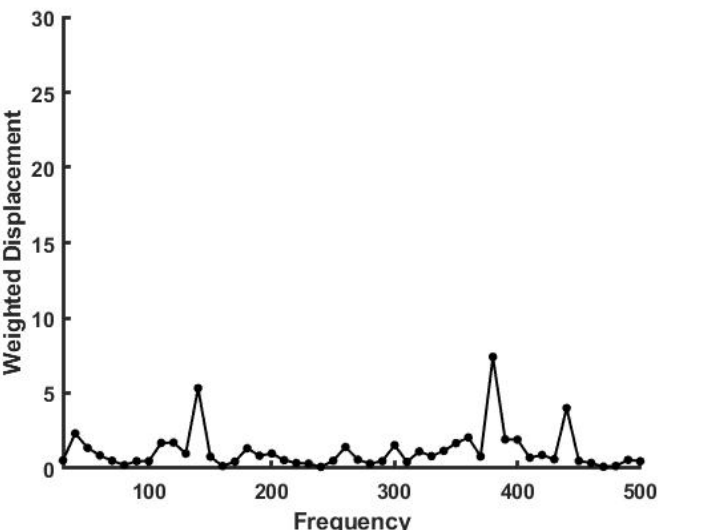
Figure 2. Weighted displacement in μ m vs frequency in Hz for skin in vivo over the biceps muscle. Skin is a composite material containing cells, collagen fibers, blood vessels and subcutaneous components including muscle.